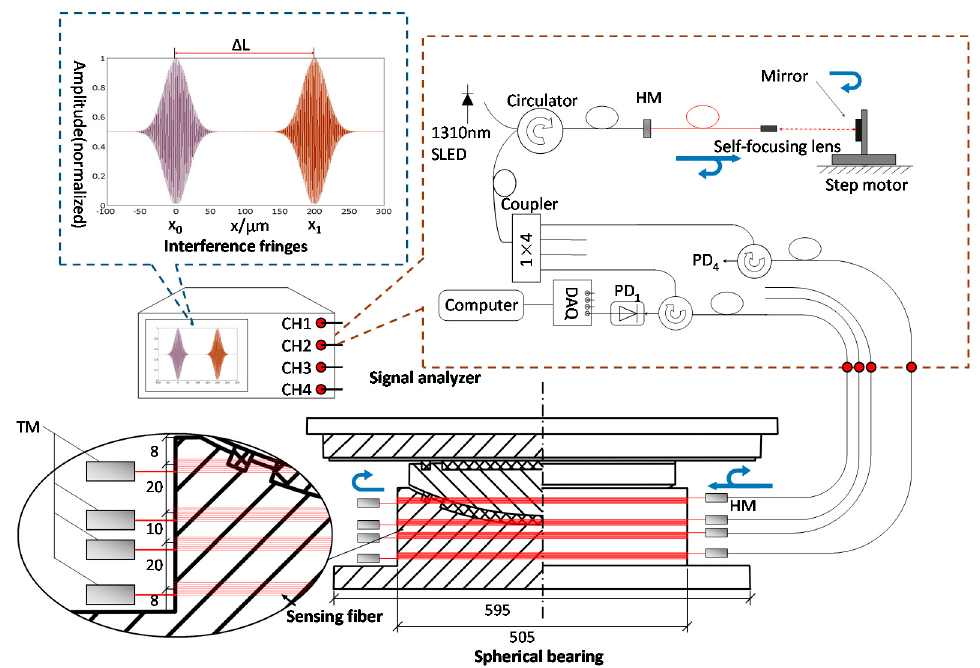
Figure 1. The diagram of the SLMI measurement system connecting with the spherical bearing. SLED: super-luminescent emitting diode; HM: half-reflection mirrors; TM: total mirrors; PD: photonic-detector; DAQ: data acquisition system.